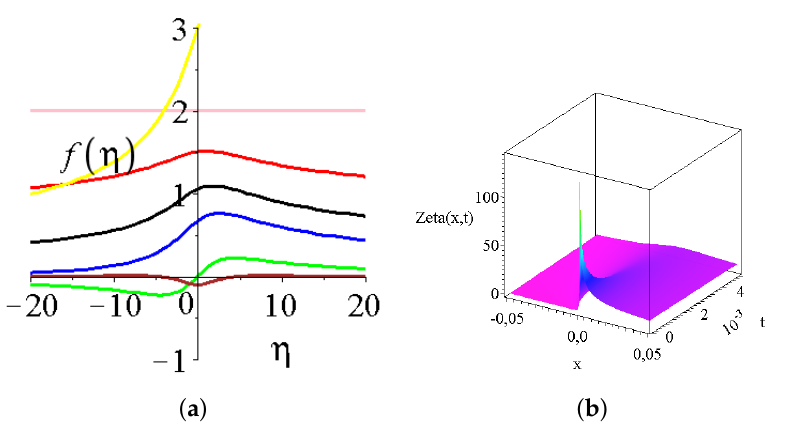
Figure 2. The shape function and the solution of the wave height. ( a ) The shape functions of the wave height (5) are presented for various self-similar exponents. The yellow, pink, black, blue, red, green and brown curves are for α = − 1/2,0,1/3,1/2,2/3,1 and 2, respectively. The integration constants c 1 , c 2 were set to unity, and water depth d = − 1. ( b ) the solution of the wave height function of ζ ( x , y = 0, t ) = t − α f ( x / t ) for the parameter set of α = 1/2, c 1 = 1, c 2 = 1, the water depth is d = −